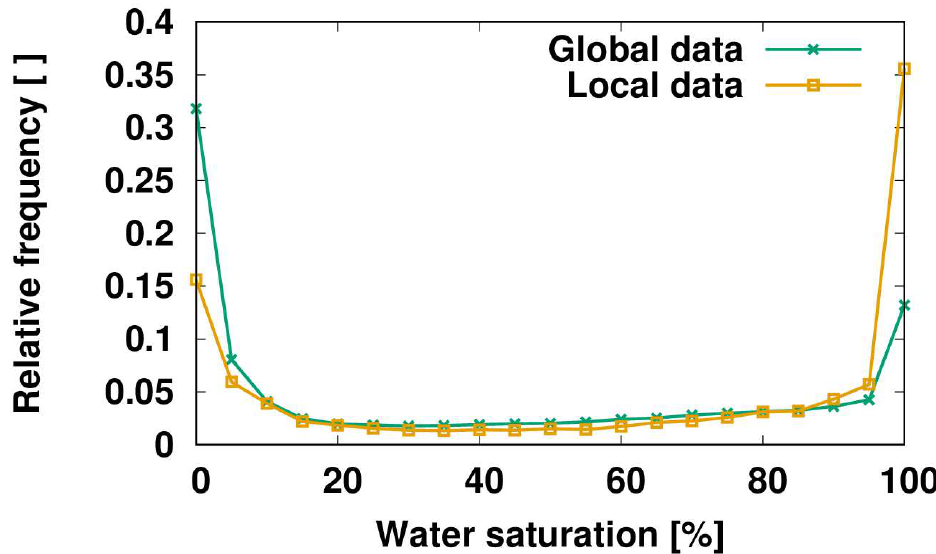
Figure 5. Saturation state of non-vascular epiphytes simulated by the LiBry model for two different climate data sets. Local data were recorded in 2014 at the Soltis weather station in Costa Rica. Global data are based on the average of the years 1958–2001 of the WATCH data set (see Porada et al. [15]) for the grid cell (2.8125° × 2.8125°) which includes Costa Rica.